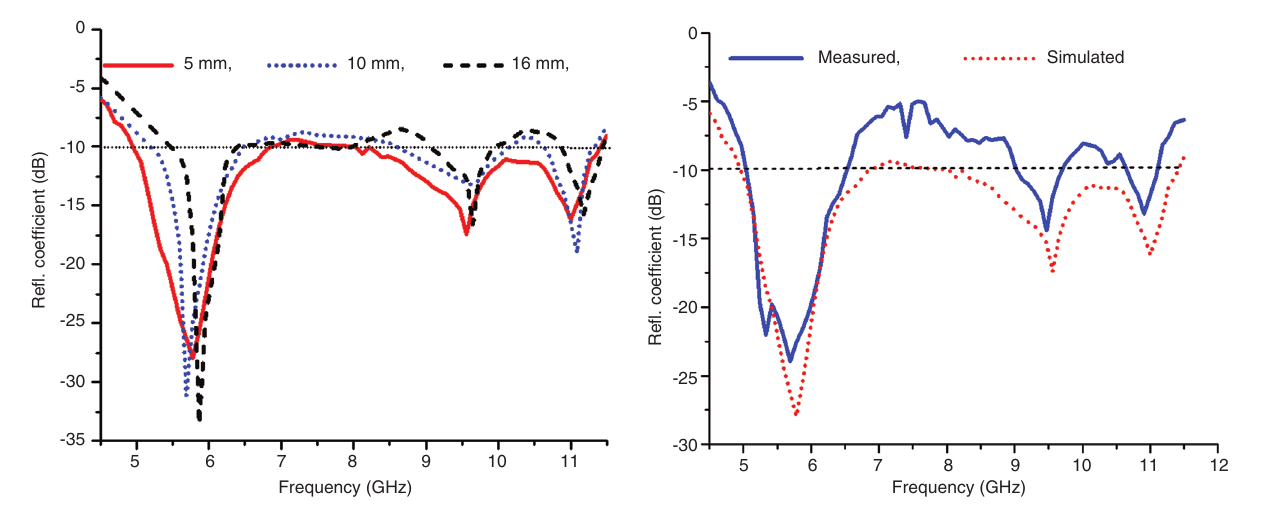
Figure 5 Simulated and measured reflection coefficient of the proposed